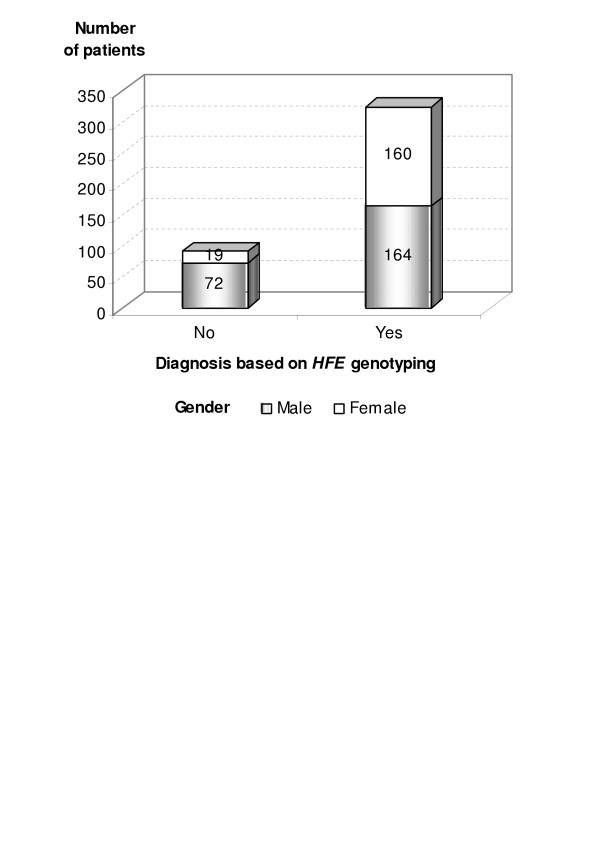
Evolution of the sex ratio: number of males and females diagnosed before and after the implementation of the genetic test.